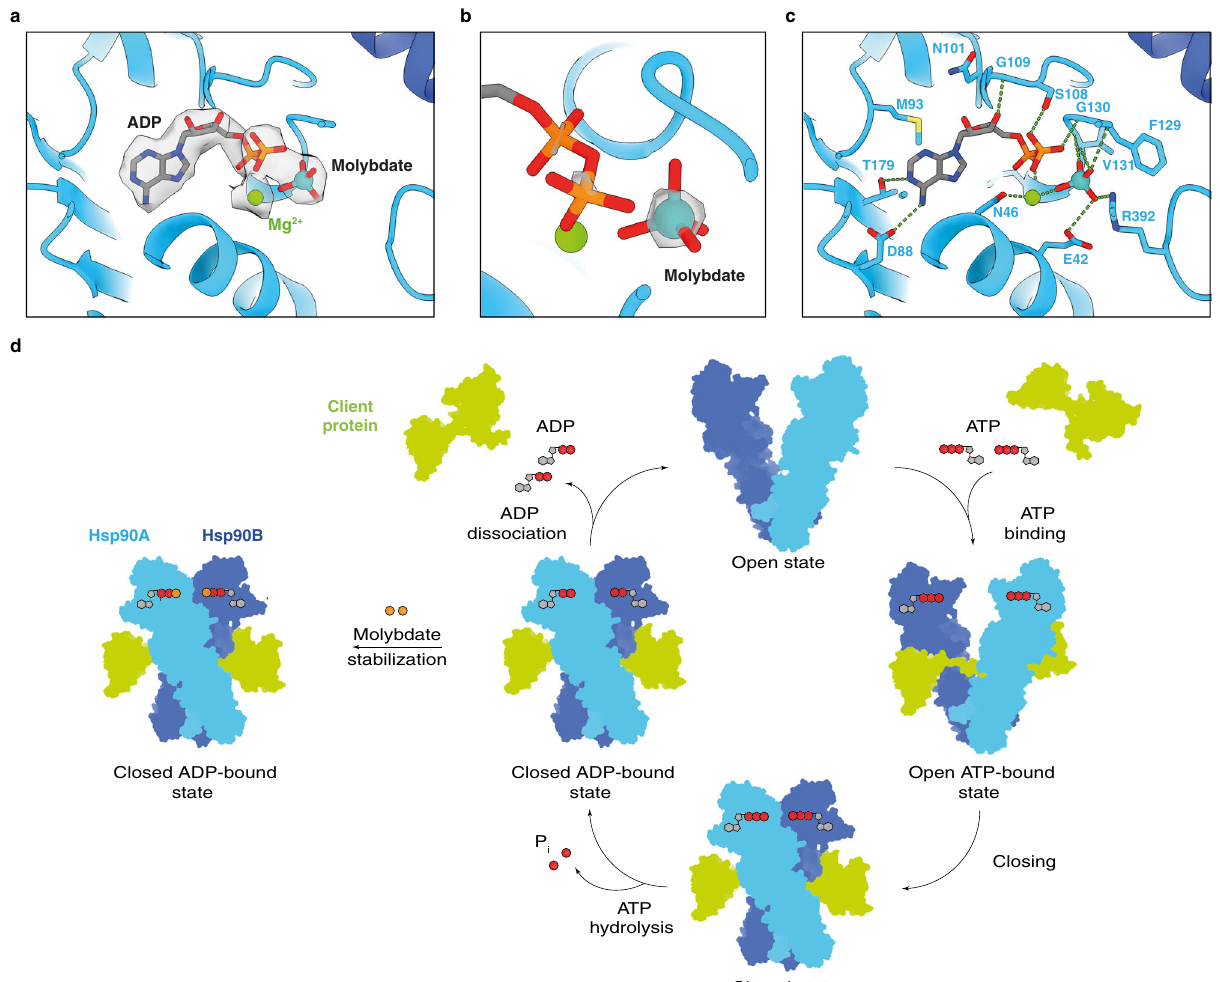
Fig.4|DetailedanalysisofthenucleotidebindingsiteofHsp90.a Close-upview ofthenucleotidebindingsiteinmoleculeAofHsp90.Theelectrondensitymapfor the molecule of ADP, molybdate anion and magnesium cation has been displayed. b Close-up view of the molybdate ion. Increased contour level of the map density shows a much stronger density relative to the α and β -phosphates. c Details of the organisation of the nucleotide binding site. Amino acid residues involved in the